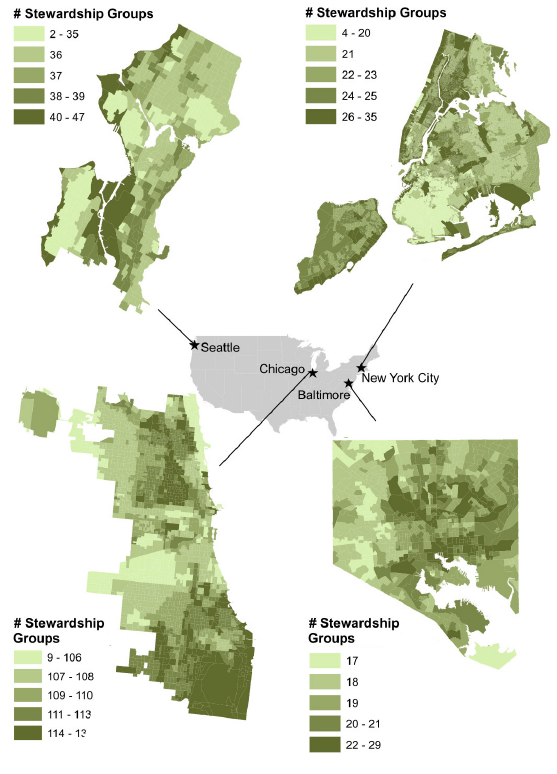
Census block group